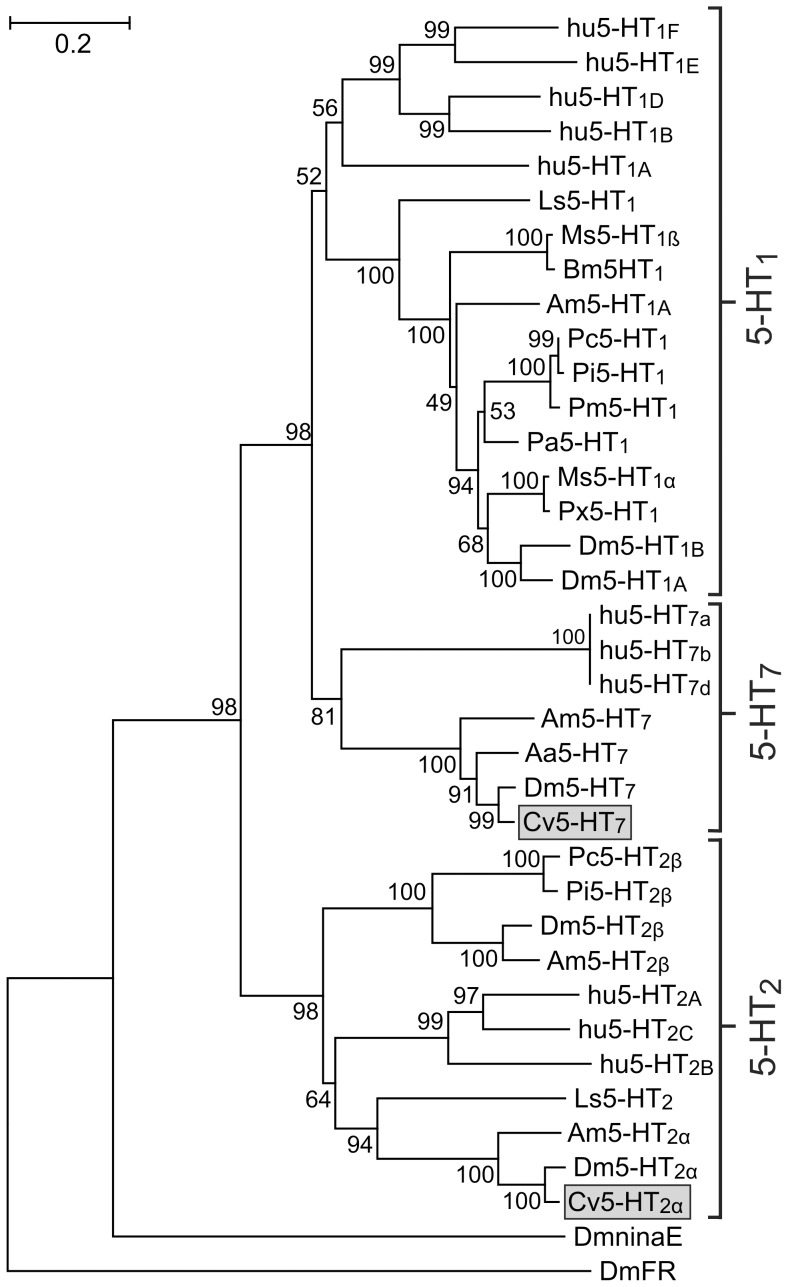
Phylogenetic analysis of Cv5-HT2α, Cv5-HT7 and 5-HT receptors from various species.Alignments were performed with BioEdit (version 7.0.8) by using the core amino-acid sequences without the variable regions of the N- and C-terminus and the IL3. Genetic distance was calculated with MEGA 5. Receptor sequences and their accession numbers are listed in the order illustrated: human (hu)5-HT1F (NP000857), hu5-HT1E (NP000856), hu5-HT1D (NP000855), hu5-HT1B (NP000854), hu5-HT1A (NP000515), Lymnaea stagnalis (Ls)5-HT1 (AAA29290), Manduca sexta (Ms)5-HT1ß (DQ840516), Bombyx mori (Bm)5-HT1 (CAA64862), Apis mellifera (Am)5-HT1A (CBI75449), Procambarus clarkii (Pc)5-HT1 (ABX10973), Panulirus interruptus (Pi)5-HT1 (AAS18607), Penaeus monodon (Pm)5-HT1 (AAV48573), Periplaneta americana (Pa)5-HT1 (CAX65666), Ms5-HT1α (ABI33826, Papilio xuthus (Px)5-HT1 (BAD72868), Dm5-HT1B (CAA77571), Dm5-HT1A (CAA77570), hu5-HT7a (NP000863), hu5-HT7b (NP062874), hu5-HT7d (NP062873), Am5-HT7 (CAJ28210), Aedes aegypti (Aa)5-HT7 (AAG49292), Dm5-HT7 (AAF57104), Calliphora vicina (Cv)5-HT7 (this study, CCF77366), Pi5-HT2β (AAS57919), Pc5-HT2ß (ABX10972), Dm5-HT2ß (AAN13390), Am5-HT2β (CBX90121), hu5-HT2A (NP000612), hu5-HT2C (NP000859), hu5-HT2B (NP000858), Ls5-HT2 (ACC16969), Am5-HT2α (CBX90120), Dm5-HT2α (CAA57429), Cv5-HT2α (this study, CCF77376), D. melanogaster ninaE-encoded rhodopsin 1 (DmninaE; AFF55712) and D. melanogaster FMRFamide receptor (DmFR; AAF47700). The numbers at the nodes of the branches represent the percentage bootstrap support for each branch. The scale bar allows conversion of branch lengths to genetic distance between clades.